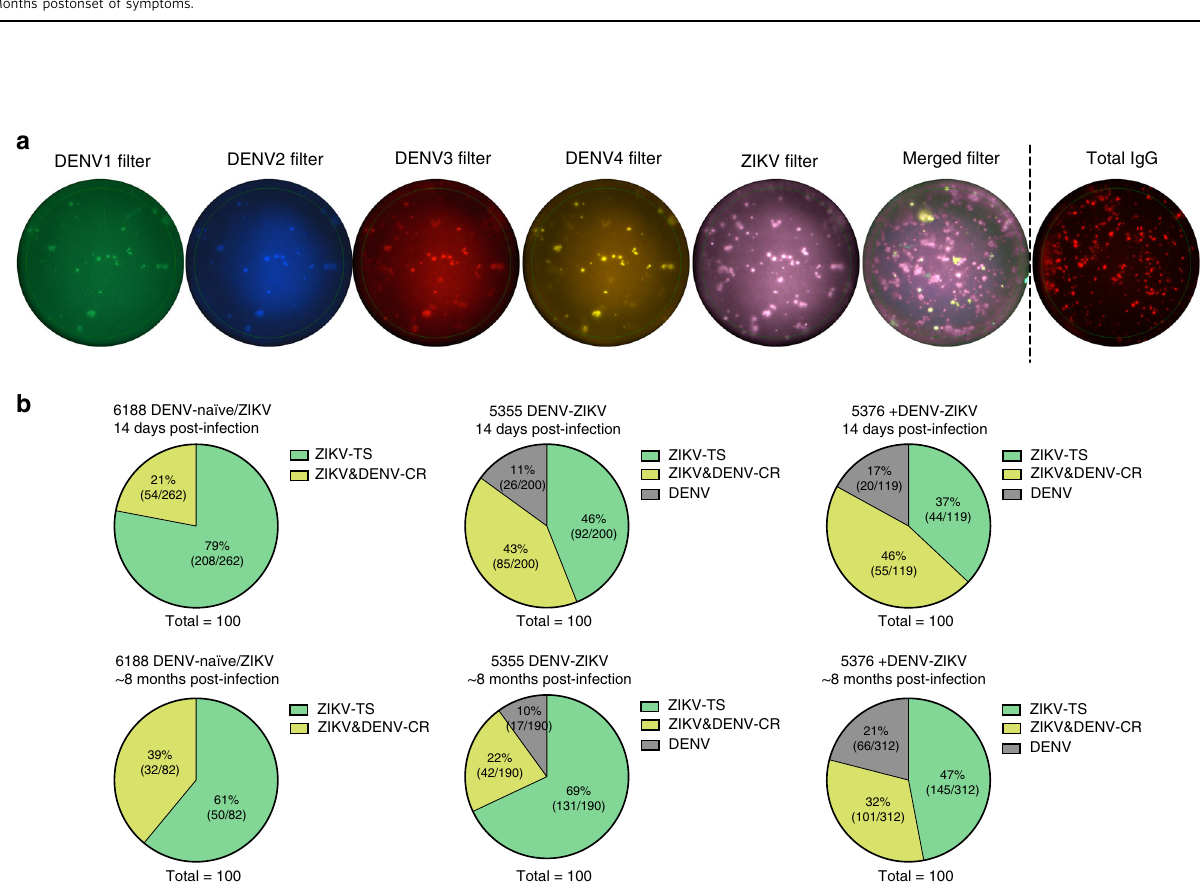
Fig. 1 Type-speci fi c and cross-reactive IgG-secreting MBC in ZIKV + patients. MBC responses in patients with RT-PCR-con fi rmed ZIKV infection and no (DENV-naïve/ZIKV), one (DENV-ZIKV), or more than one ( + DENV-ZIKV) prior DENV infection(s) were analyzed by the Multi-Color FluoroSpot assay at ~14 days and ~8 months postinfection. a Representative images of activated MBCs from patient 6188 (DENV-naïve/ZIKV) after ~14 days postinfection. Antigen speci fi city of MBC responses to ZIKV and the four DENV serotypes are shown as spots represented in each fi lter. The total ASC of activated MBCs was analyzed in parallel (Total IgG). b Proportion of antigen-reactive MBCs to ZIKV, ZIKV and DENV, and DENV in representative patients from the DENV-naïve/ZIKV, DENV-ZIKV, and + DENV-ZIKV groups at ~14 days and ~8 months postinfection. ZIKV-TS, MBCs that react with ZIKV and not with any DENV serotype; ZIKV&DENV-CR, MBCs that react with ZIKV and at least with one DENV serotype; DENV, MBCs that react with one or more DENV serotypes but not with